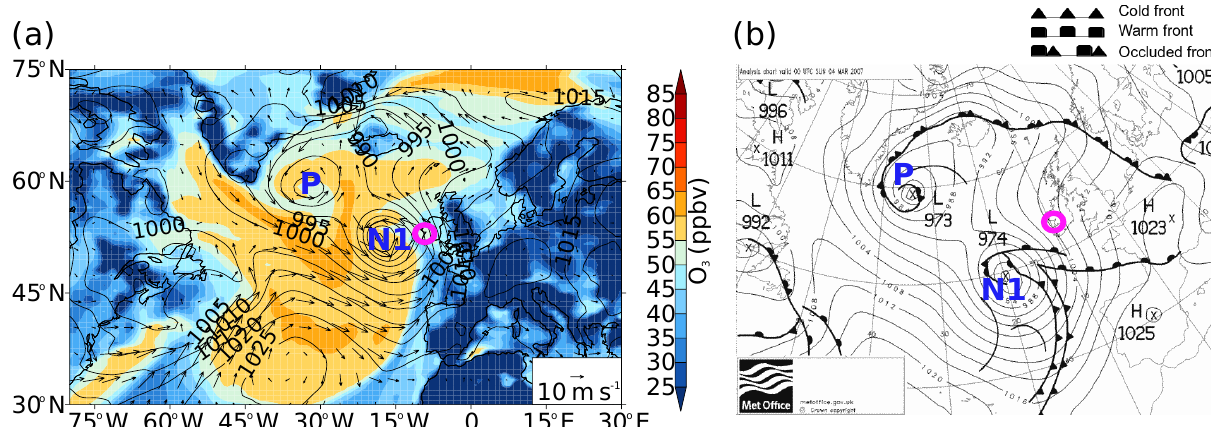
Figure 3. (a) 1000hPa MACC O 3 (color) and horizontal wind vectors (10ms − 1 reference arrow) and MSLP (solid contours, 5hPa intervals) on 4 March 2007 at 00:00UTC, 12h prior to maximum ζ 850 for N1 cyclone (N1: 52 ◦ N, 19 ◦ W). Parent low (P: 59 ◦ N, 34 ◦ W) is located between Greenland and Iceland. Mace Head indicated by the pink open circle. (b) Analysis chart for 4 March 2007 at 00:00UTC from UK Met Office (available from archive at http://www.wetterzentrale.de/topkarten/tkfaxbraar.htm, retrieved 19 May 2015) shows the complex fronts associated with the N1 cyclone and the parent low. Mace Head (pink circle) is located to the north of the N1 warm front.